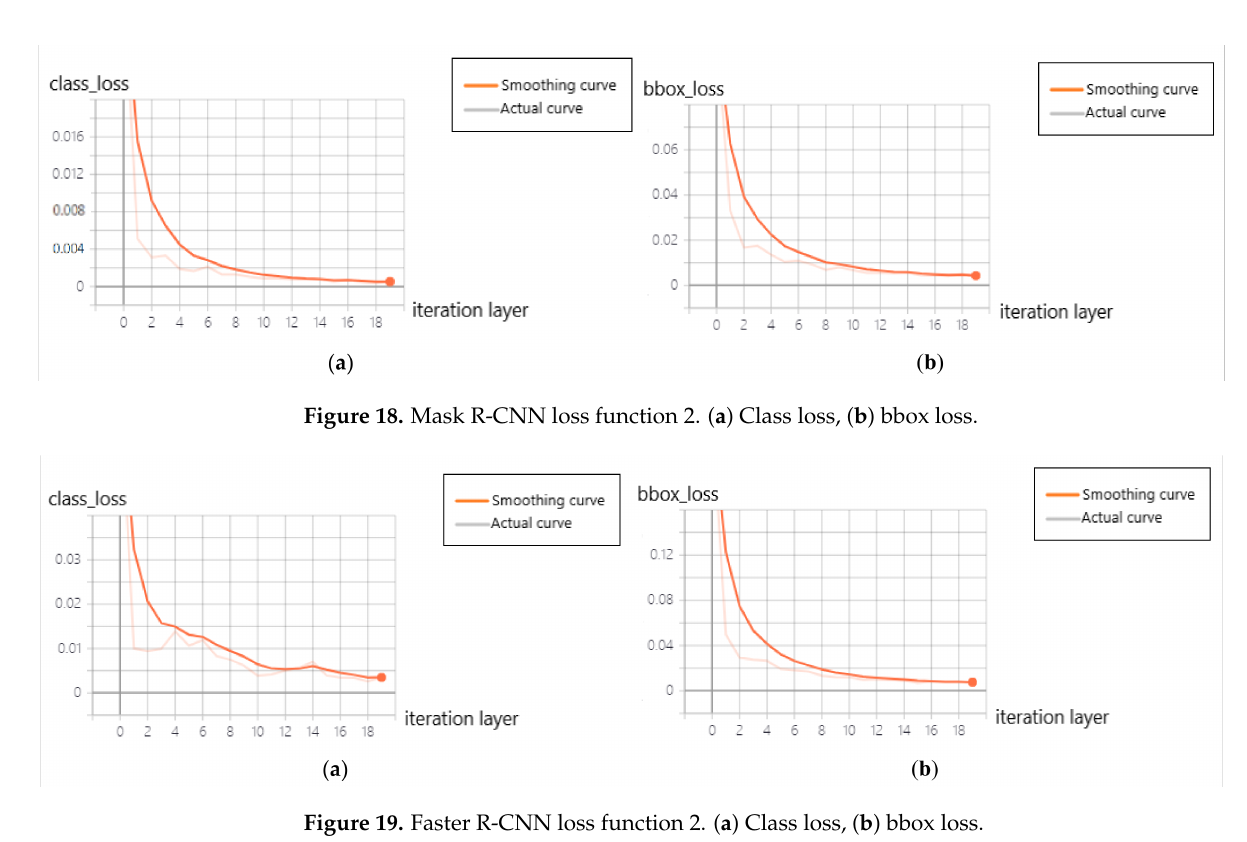
Figure 19. Faster R-CNN loss function 2. ( a ) Class loss, ( b ) bbox loss. (3) The total number of iterations of the model is 30: